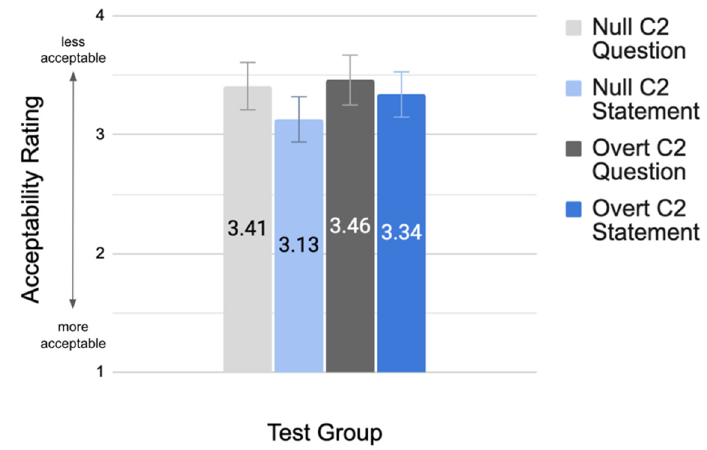
Figure 1. Baseline group mean acceptability ratings.